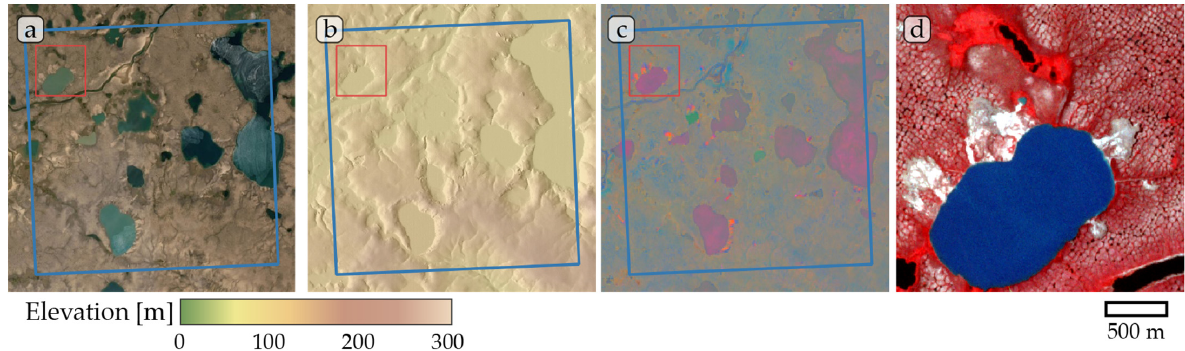
Figure A3. Study site Herschel Island 02. ( a ) ESRI satellite layer, ( b ) ArcticDEM superimposed with hillshade, ( c ) Tasseled Cap trend visualization, ( d ) PlanetScope satellite image (NIR-R-G) acquired on 02 September 2019. Blue box, 10 × 10 km study site. Red box detailed view of ( d ). Figure A4. Study site Horton 01. ( a ) ESRI satellite layer, ( b ) ArcticDEM superimposed with hillshade, ( c ) Tasseled Cap trend visualization, ( d ) PlanetScope satellite image (NIR-R-G) acquired on 14 July 2019. Blue box, 10 × 10 km study site. Red box detailed view of ( d ).